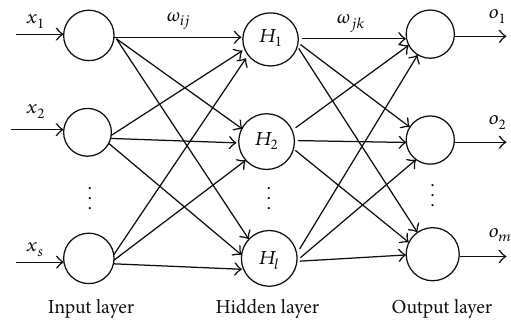
Figure 1: The topology structure of